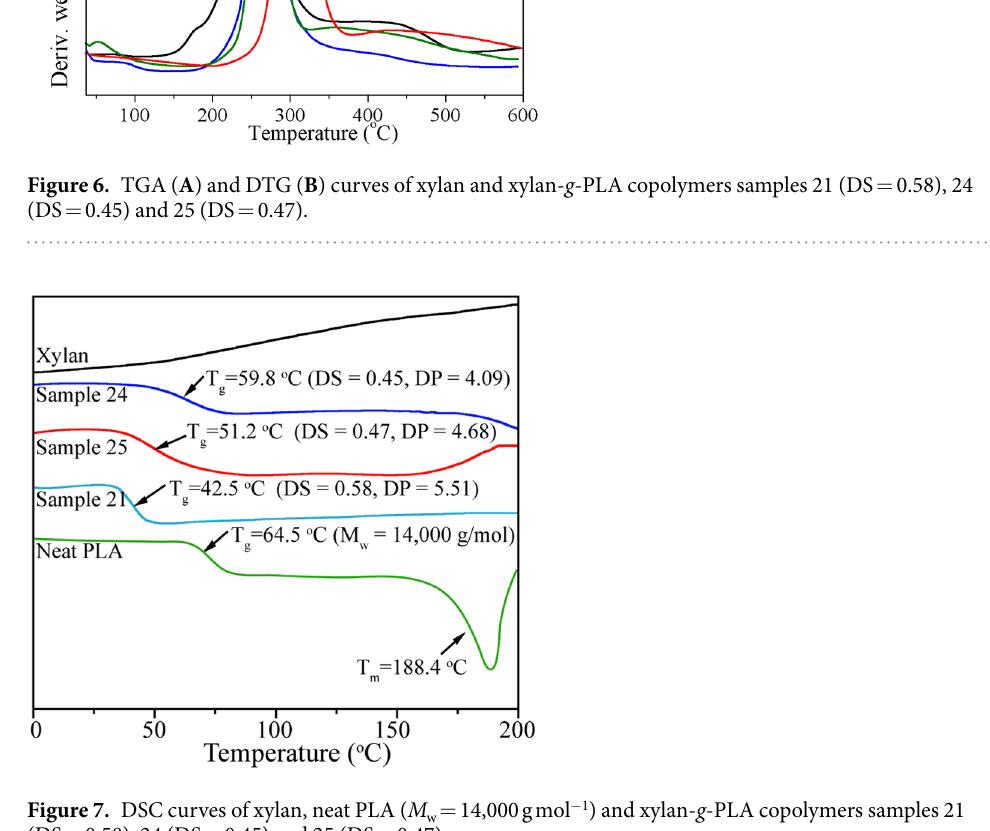
Figure 7. DSC curves of xylan, neat PLA ( M w = 14,000 g mol − 1 ) and xylan- g -PLA copolymers samples 21 (DS = 0.58), 24 (DS = 0.45) and 25 (DS =